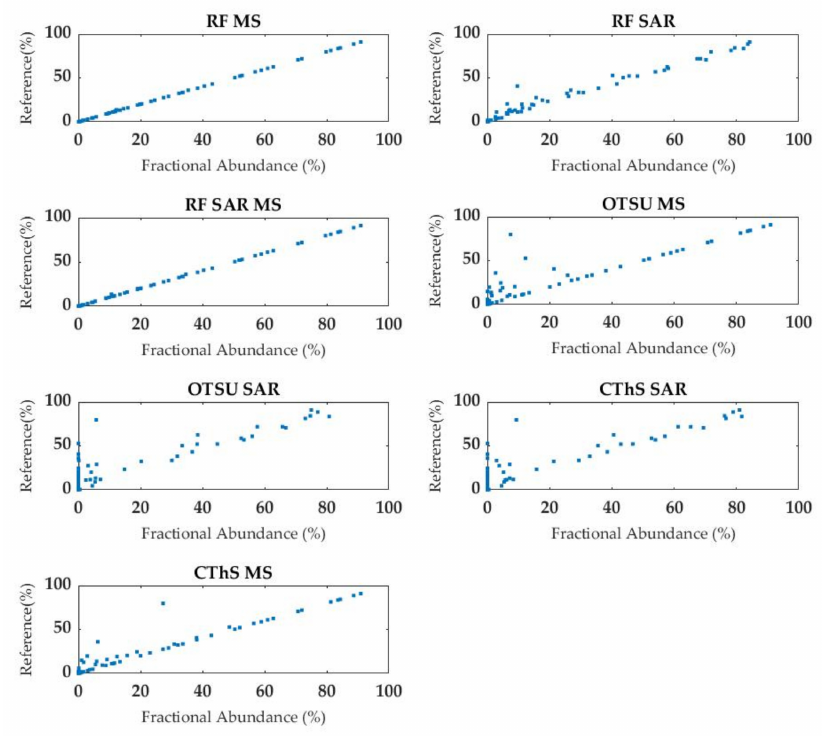
Figure 10. Plots of the fractional abundance of water (%) calculated over a regular 500 m resolu- tion grid for the flood event 2017 (Enza river): results obtained by supervised and unsupervised methodologies ( x -axis) against a reference flood delineation ( y